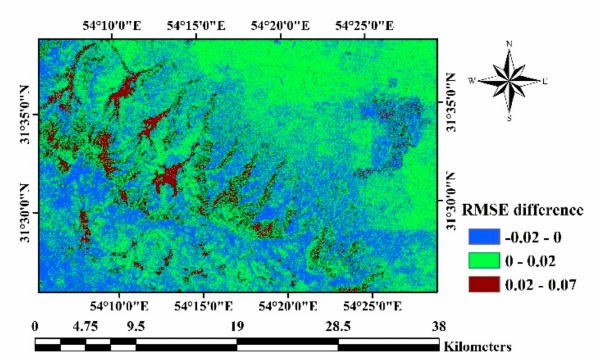
Figure 15. Di ff erence between RMSE map of HANTS and M-SSA. Positive values show that the RMSE in HANTS is higher than M-SSA and vis